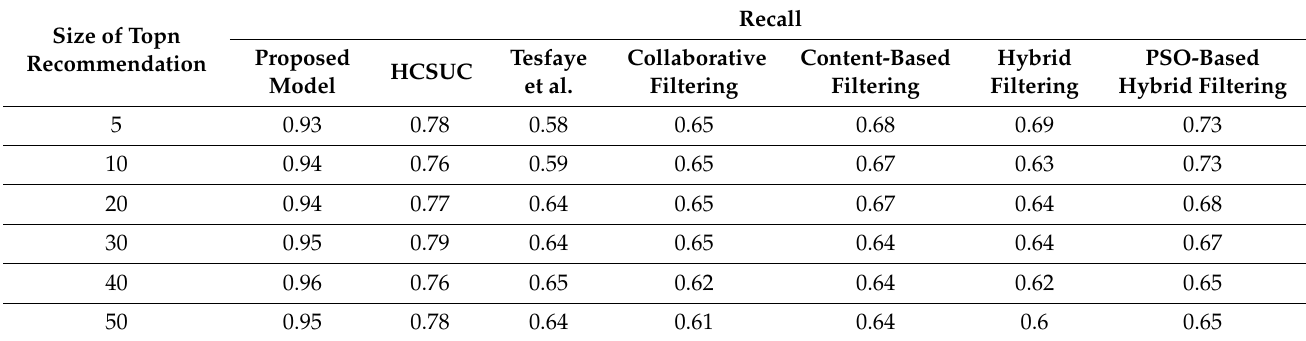
Table 6. Recall according to the Topn Recommendation (Considering Dataset 1 [43]).